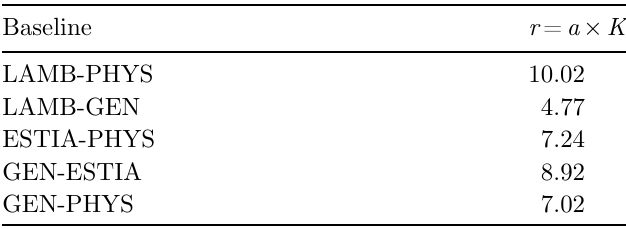
Table 12. Horizontal circular con fi dence region at 95% con fi dence level (fully constrained solution).